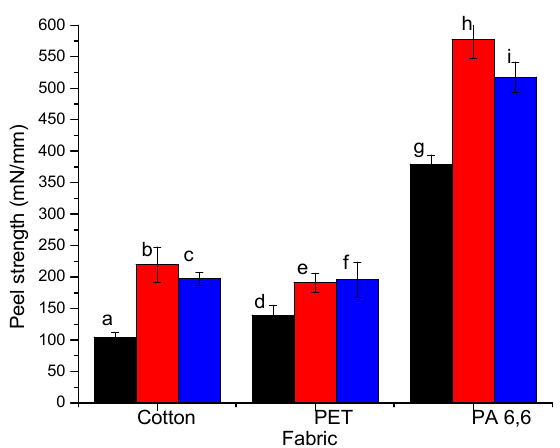
Figure 9. Peel strength for cotton, PET, and PA 6,6 fabrics adhered using NFC: ( a , d , g ) NFC with no additives, ( b , e , h ) NFC+PEI, and ( c , f , i ) NFC+P(GMA-OEGMA) mixtures.